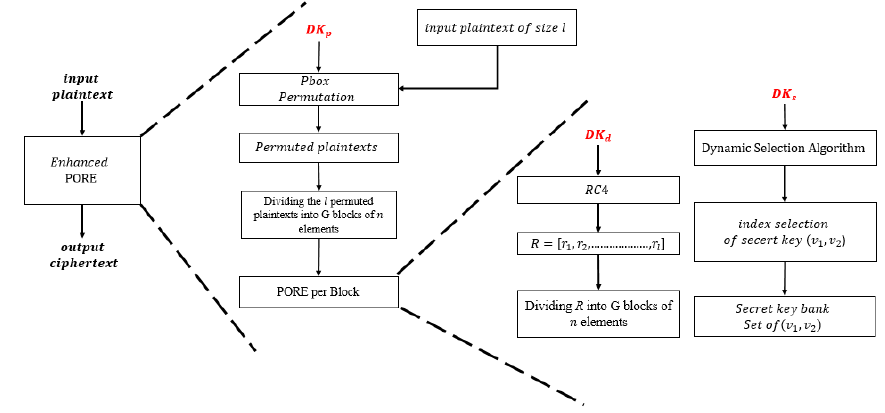
Figure 3: Enhanced PORE Flow